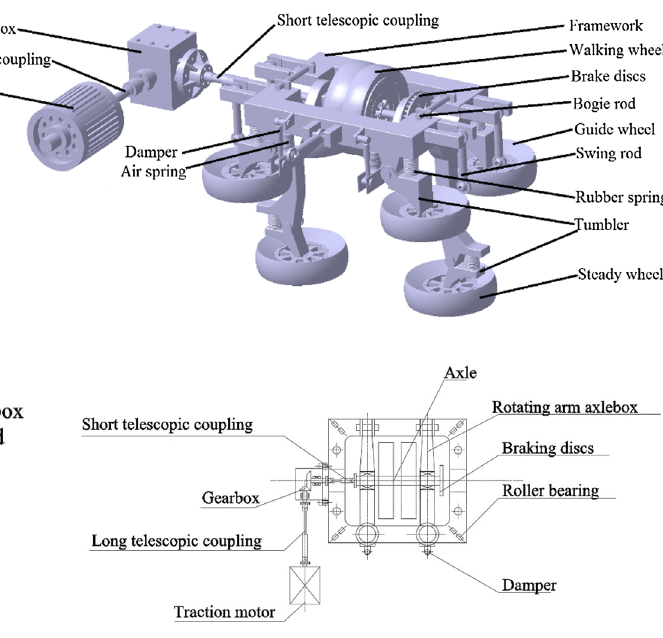
Fig. 6 Schematic diagram of the traction